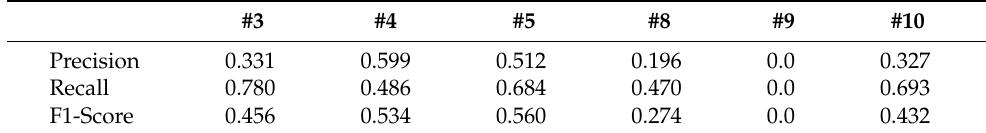
Table 3. Quantitative results of the Precision, Recall, and F1-Score for the 5 test images. The numbers with a # correspond to the numbers in Table 1.